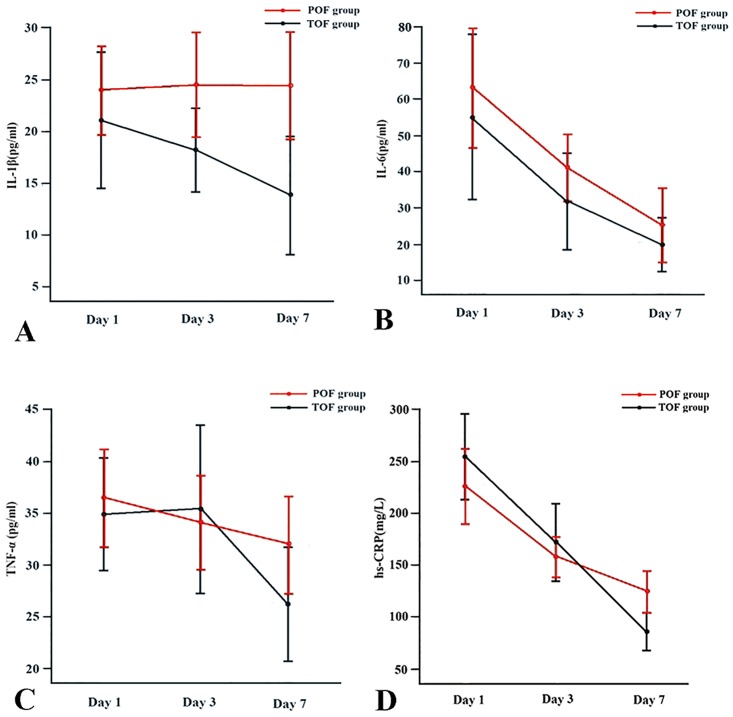
Sequential changes in the values of IL-1β (A), IL-6 (B), TNF-α (C) and hs-CRP (D) in the POF and TOF groups.